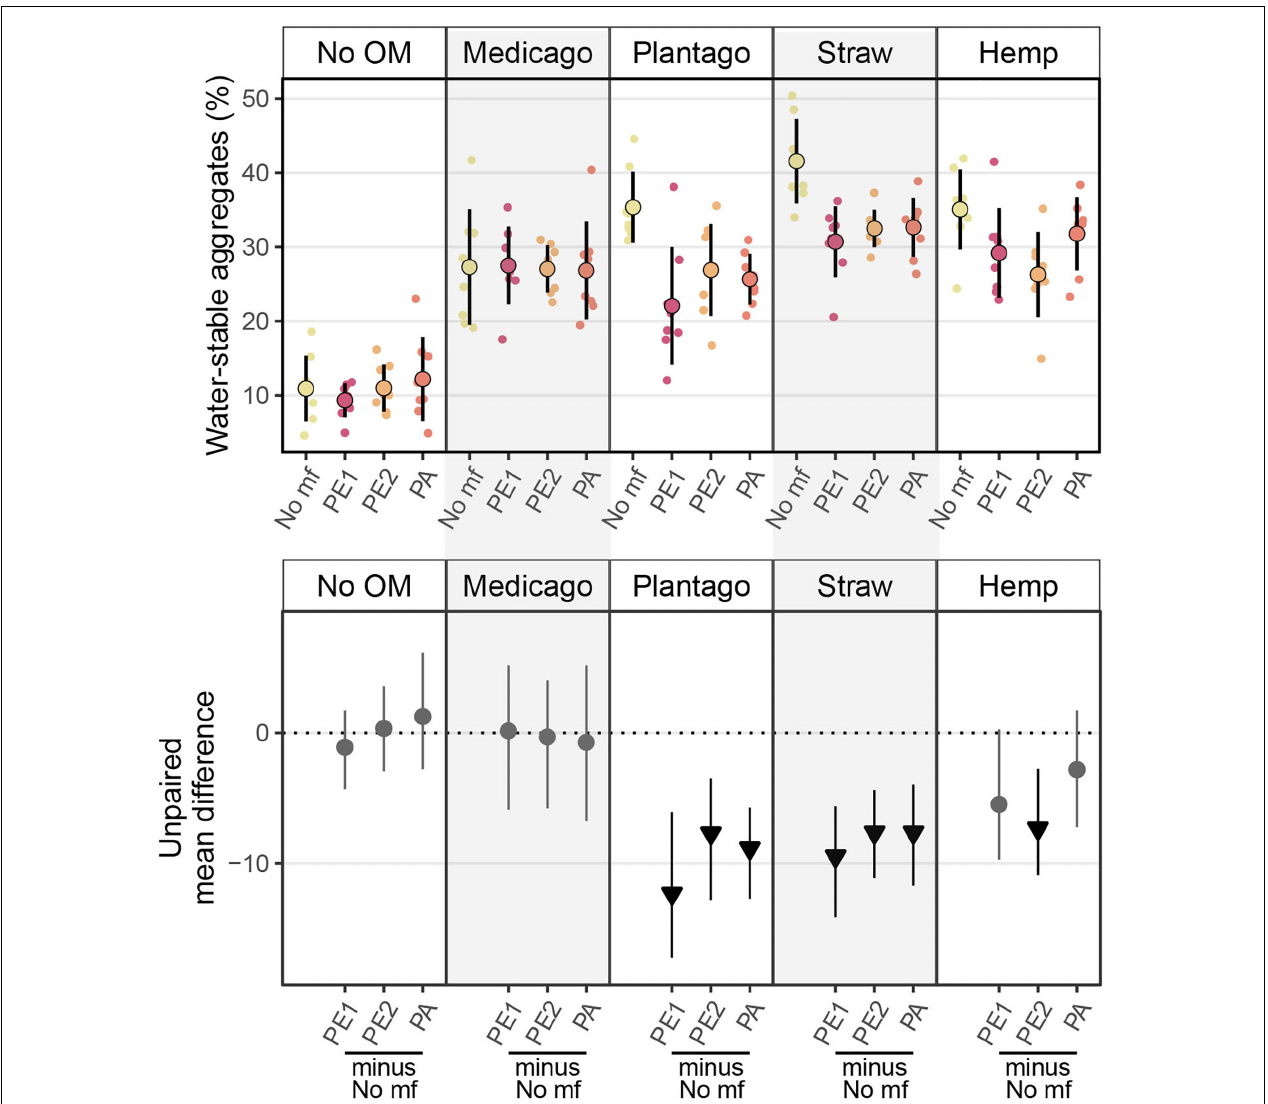
FIGURE 1 | Effects of microplastic fibers on soil water stable aggregates (WSA in %) with the addition of different types of organic matter. The upper panel shows the raw data of water stable aggregates, data distributions are aligned with corresponding mean and standard deviation ( n = 8 for each treatment). The lower panel shows the unpaired mean differences of the microplastic fiber addition and control under different organic matter addition. Circles and triangles represent the effect size mean (unpaired mean; effect magnitude) and the vertical lines the corresponding confidence intervals (effect precision). Negative (arrow head down) effect sizes and corresponding CIs of treatment compared to control are depicted in black while neutral effects (circle) are colored in gray; neutral effects occur when the CIs overlap the dashed zero line (line of no effect). “No OM” represents no organic matter addition, “No mf” represents no microplastic fiber addition.